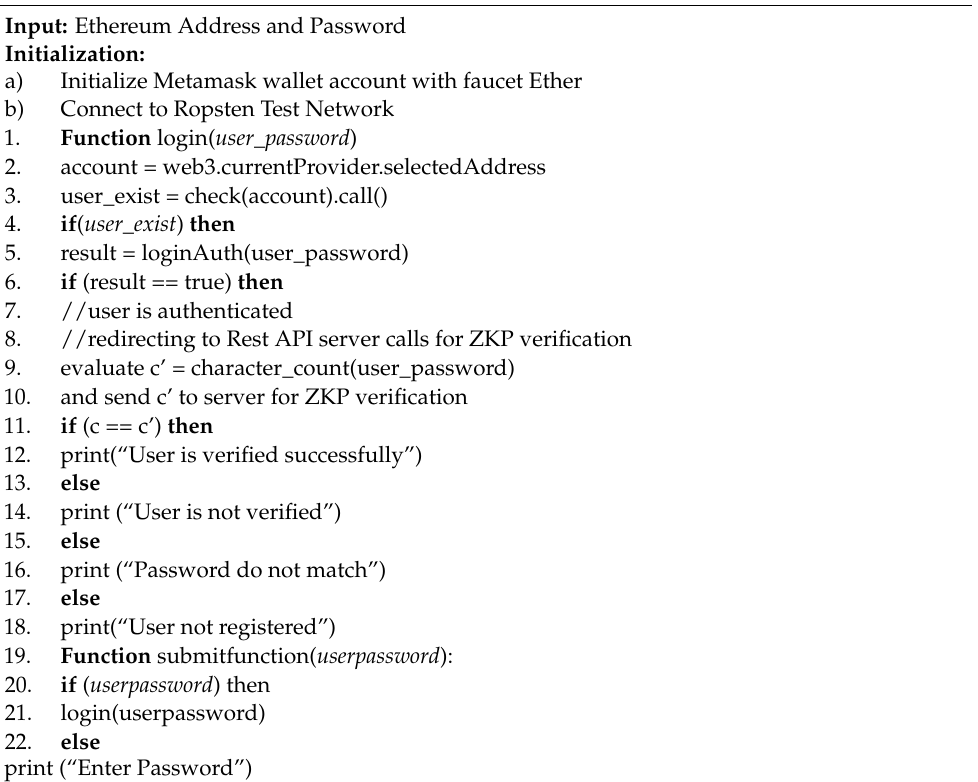
Algorithm 2: Algorithm for Sign-In/Login